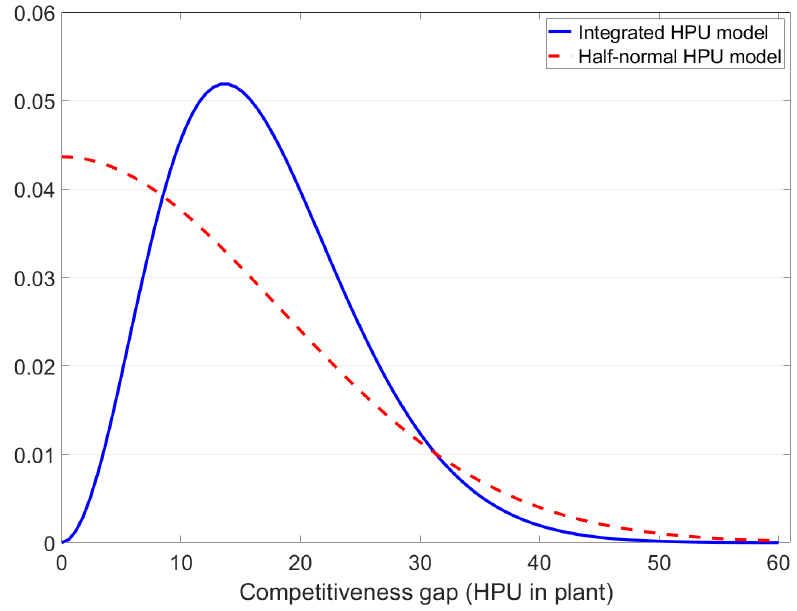
Figure 7. Probability density functions of inefficiency for integrated model and half-normal